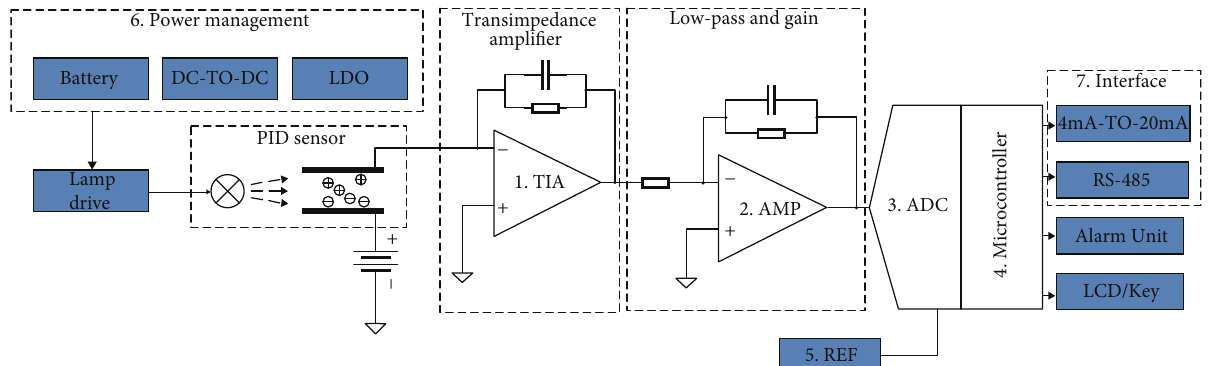
Figure 5: Schematic diagram of the miniature PID.